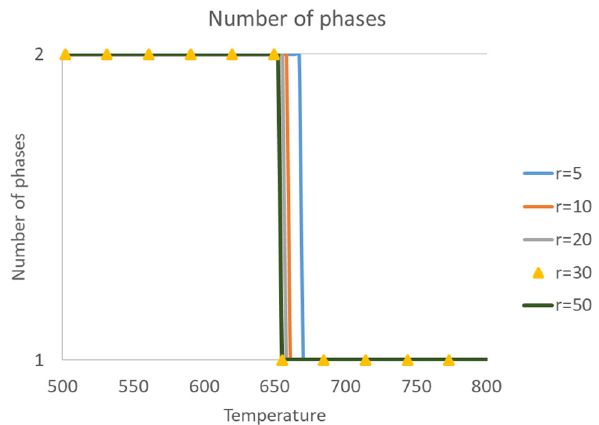
Figure 6. Number of phases at equilibrium changing with temperature under the constant overall mole concentration as 1568.7 mol/m 3.